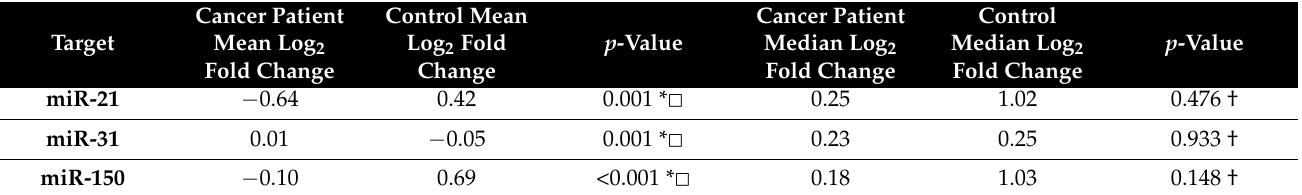
Table 5. Comparison of the mean and median expression levels of miRNA targets in the circulation of 34 independent colorectal cancer patients and 5 ‘normal’